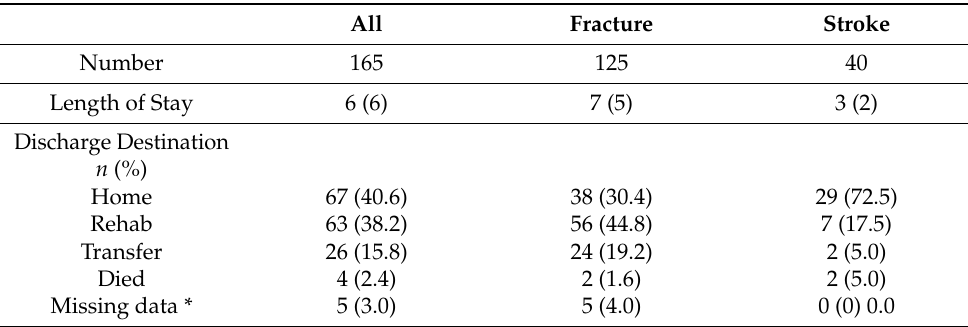
Table 2. Participant Outcomes.